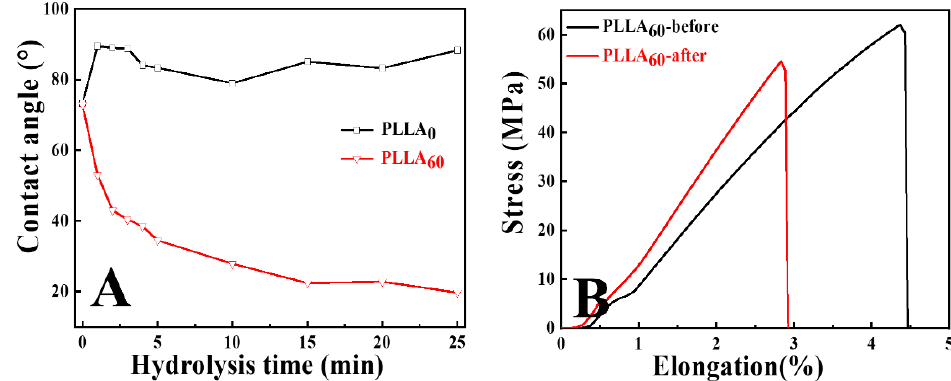
Figure 2. The hydrolysis time dependence of water contact angle in PLLA 0 and PLLA 60 ( A ) and strain–stress curves of PLLA 60 before and after hydrolysis ( B